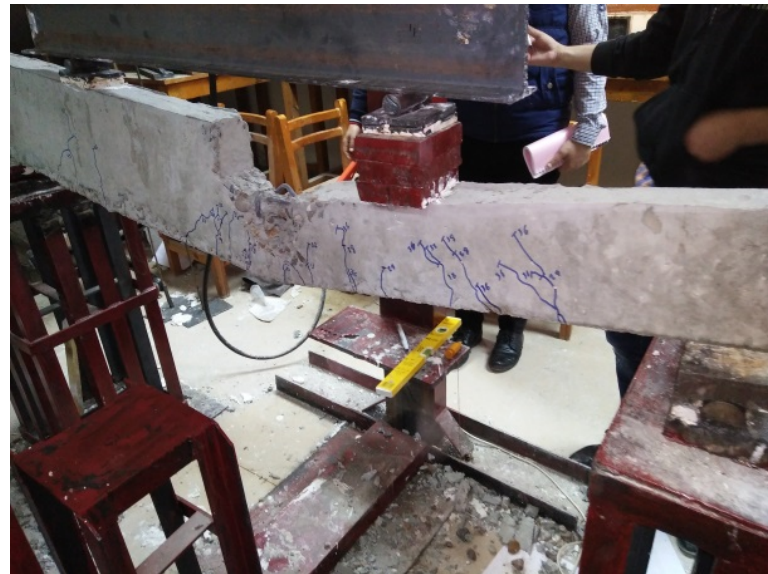
Figure 16. Crack pattern of beam B4 *.